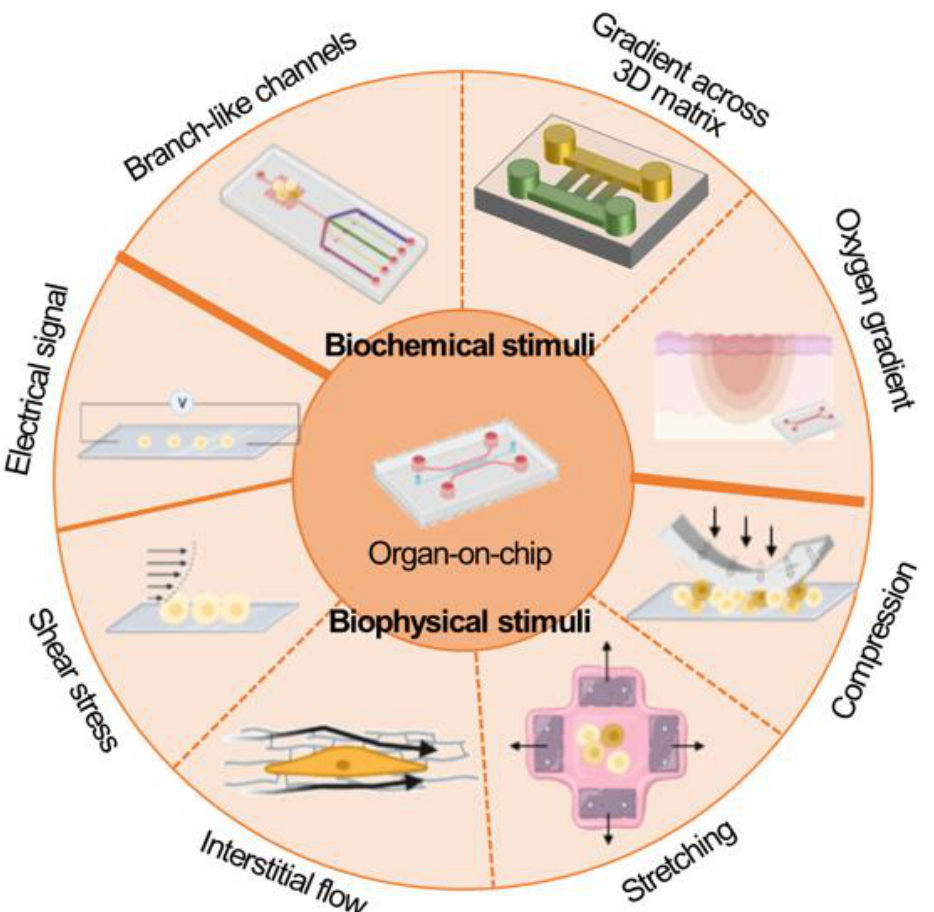
Figure 4. Biochemical and biophysical stimuli applied to organ-on-chip models.